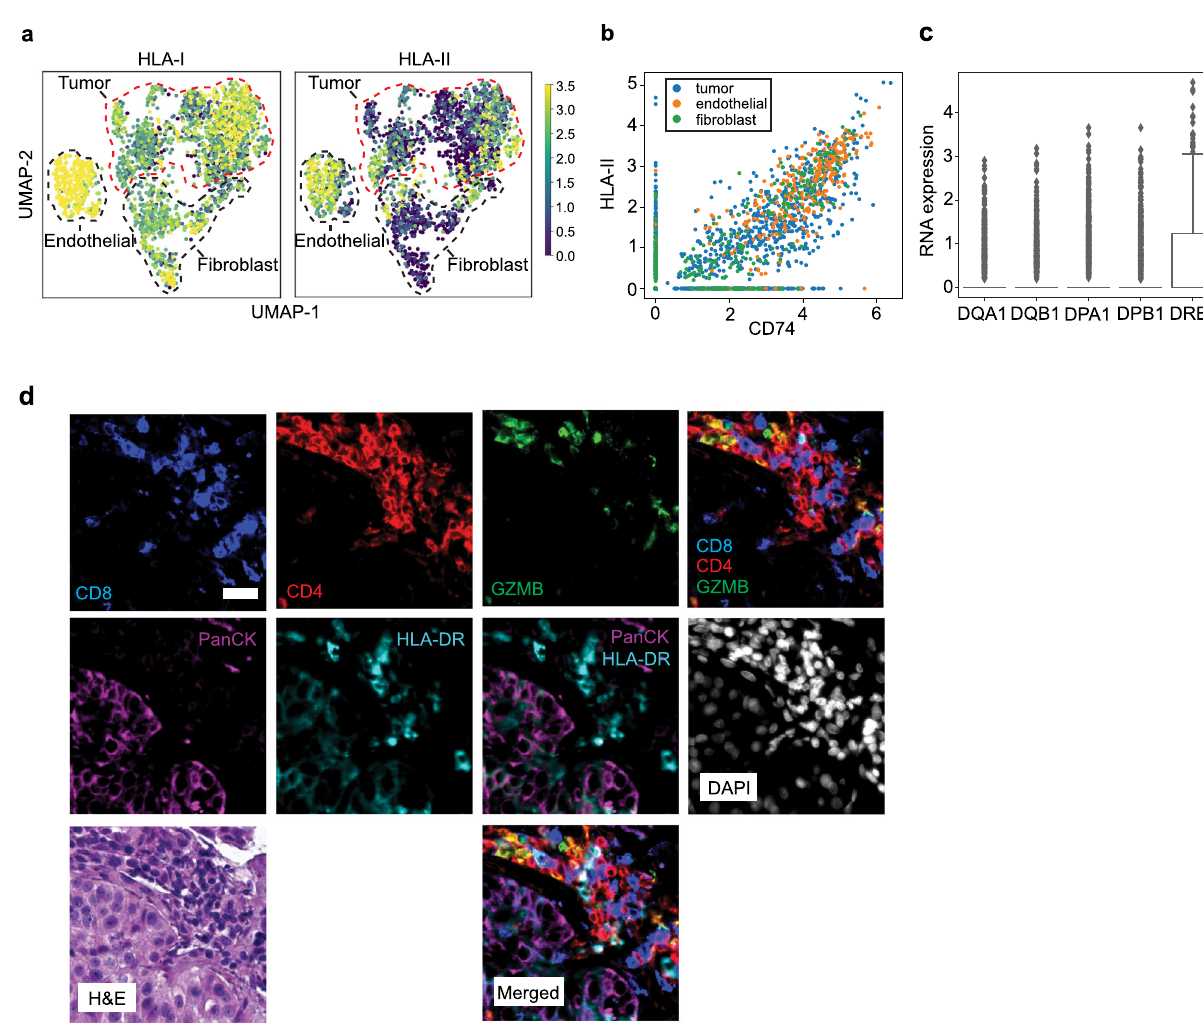
Fig. 4 A subpopulation of tumor cells express HLA class II in NSCLC. UMAP projections showing the expression of a HLA-I and HLA-II in the CD45 − fraction. HLA-I and II expression was measured by summing the expression of all the individual genes assessed in the locus. b Comparison of HLA-II and CD74 (invariant chain) expression ( R = 0.751, unadjusted p = 0, Pearson correlation test). c Boxplots show the log-transformed expression of the